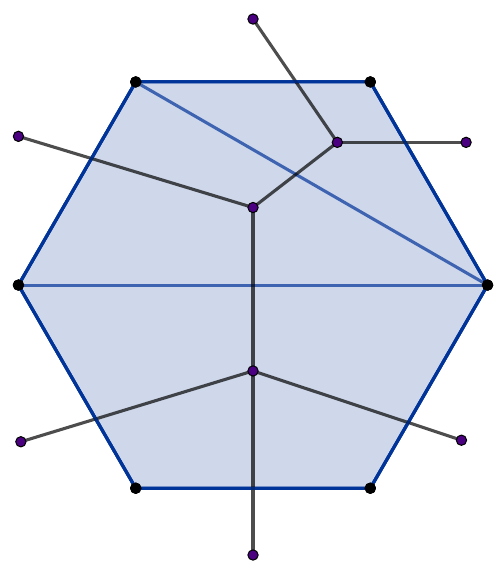
Figure 1 . Dissection (13 , 36) of a hexagon and the dual Feynman